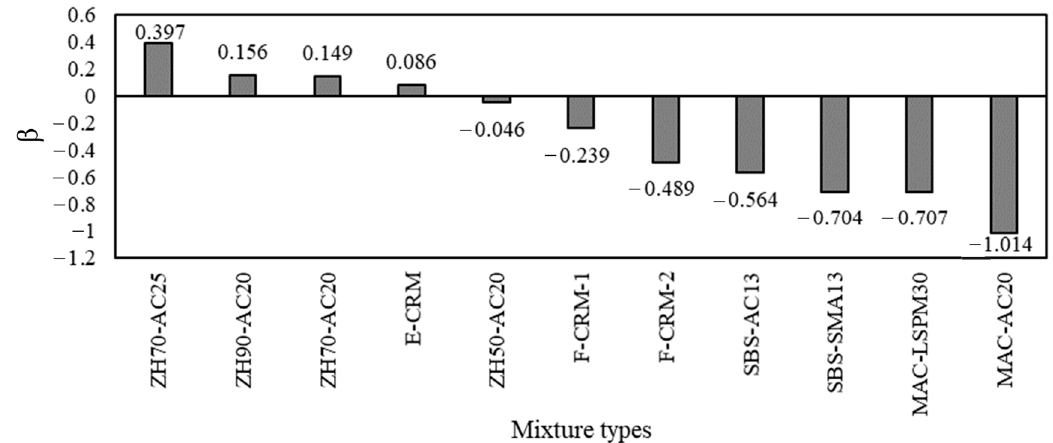
Figure 12. Comparison of shape parameters ( β )of modulus master curves.